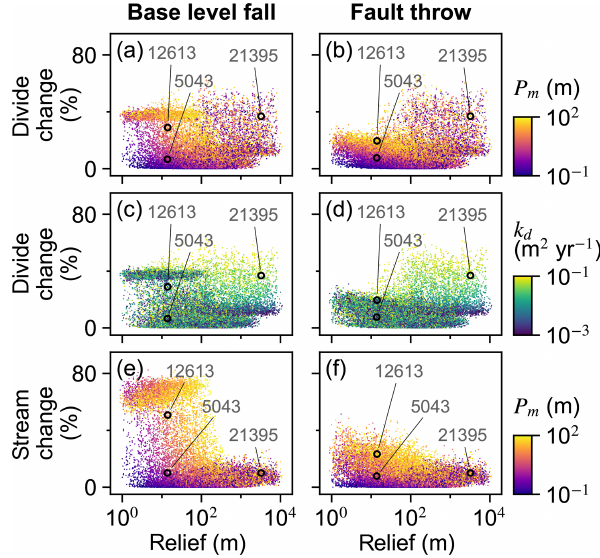
Figure 7. Landform change responses versus initial relief. Re- sponses of all trials for divide percent change (a–d) and stream per- cent change (e, f) . The labelled points are the IDs of the exemplary trials depicted in Fig. 8 and described in the